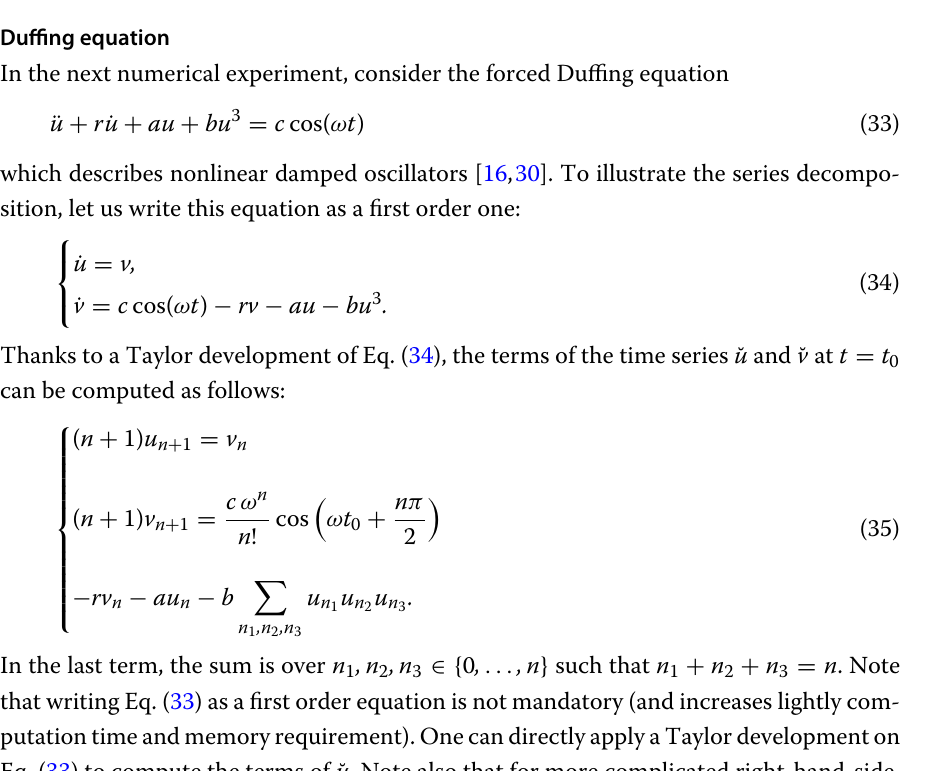
TimestepandCPUcomparison,withalmostthesamemeanerroron H .Finaltime:5000